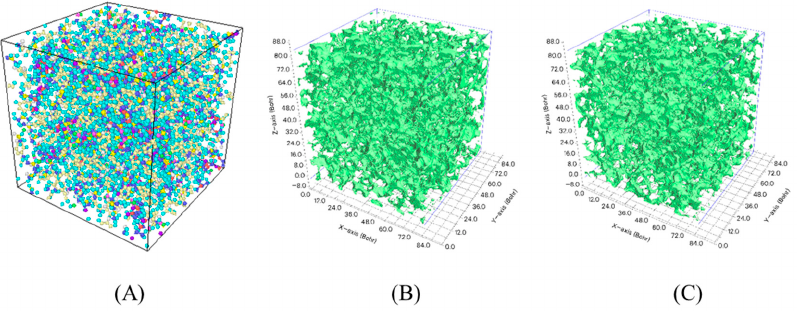
Figure 12. Free volume calculation ( A ) Molecular model; ( B ) Isosurface of primitive free region before fatigue; and ( C ) The isosurface of primitive free region after fatigue Isosurface in green and the free volume in